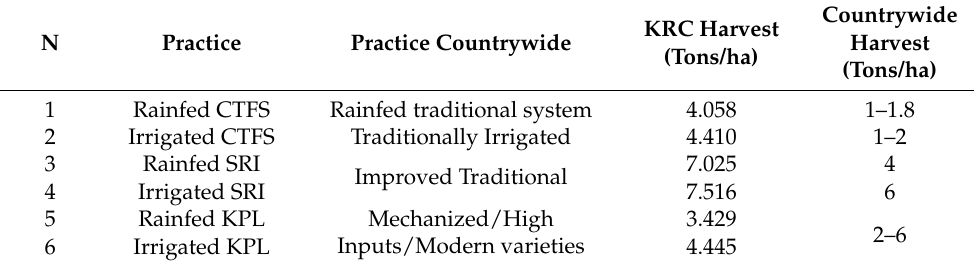
Table 8. Comparison of harvests between KRC and National Average. Comparison of current study and others